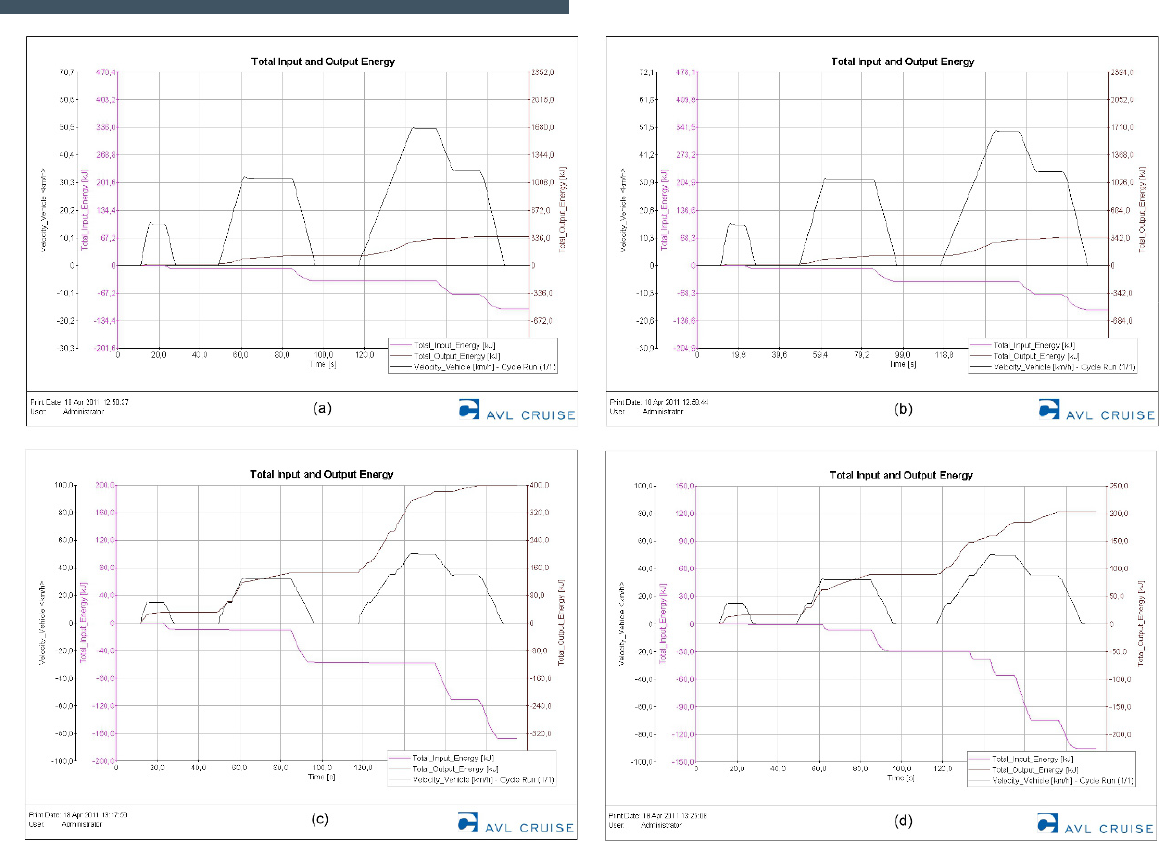
Figure 7. The energy flow in and out from the electric machine in respect of: Electric vehicle (a), Electric vehicle with range extender (b), Hybrid vehicle with CVT (c), Hybrid vehicle with planetary gearbox (d).